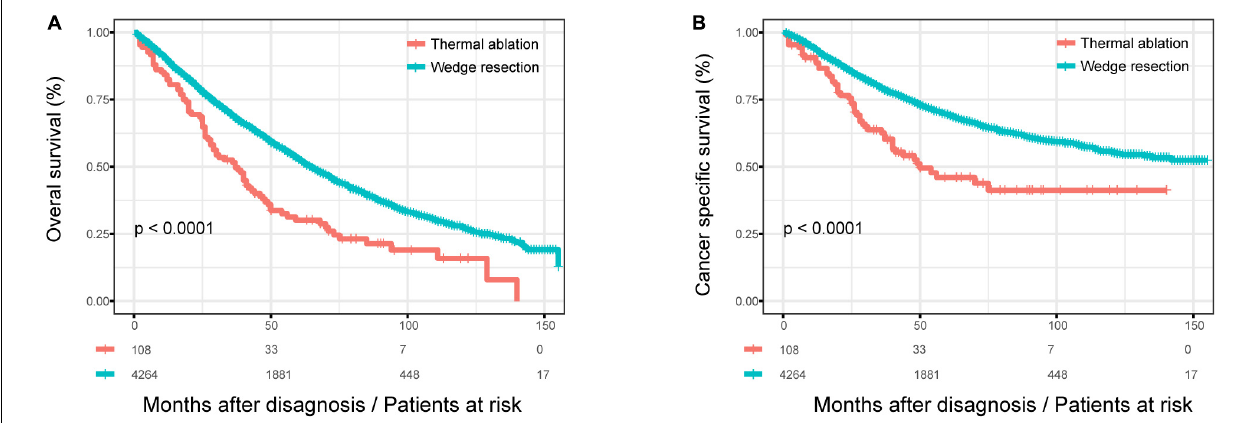
FIGURE 1 | The OS and CSS curves in stage I NSCLC patients who received thermal ablation or wedge resection. (A) The OS curve of stage I NSCLC patients who received thermal ablation or wedge resection ( χ 2 = 26.247, p < 0.0001). (B) The CSS curve of stage I NSCLC patients who received thermal ablation or wedge resection ( χ 2 = 22.453, p <